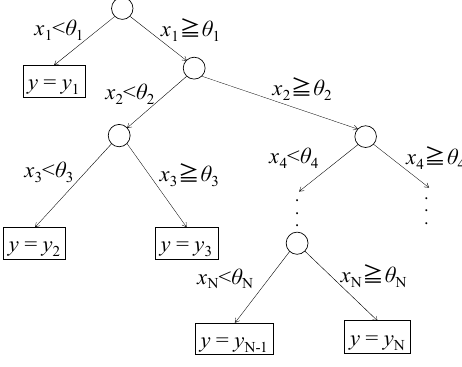
Figure 14. Random Forest.